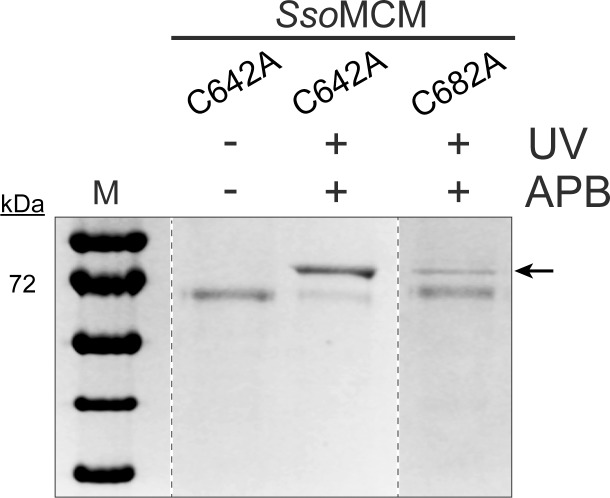
Crosslinking MCM mutants to DNA.The UV crosslinked protein-DNA product of two SsoMCM mutants and the uncrosslinked SsoMCM C642A were run on a 10% SDS- PAGE gel. The shifted protein-DNA product is indicated by a black arrow (←). In the presence of UV and APB, SsoMCM C642A shows a higher signal for the crosslinked protein-DNA product compared to C682A mutant. Rec protein ladder is used as the standard protein marker (M).